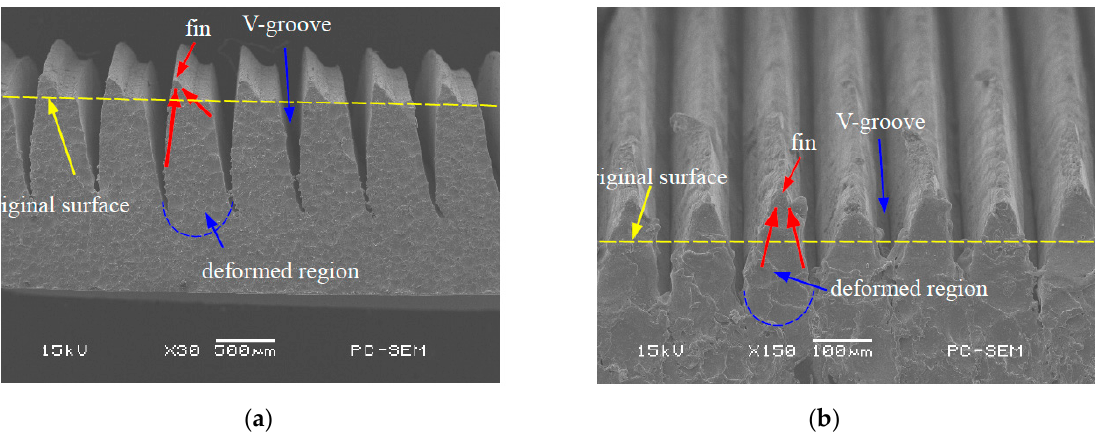
Figure 6. V-grooves by P-E processing. ( a ) d ph = 0.20 mm, a ph = 0.20 mm; ( b ) d ph = 0.16 mm, a ph = 0.20 mm.